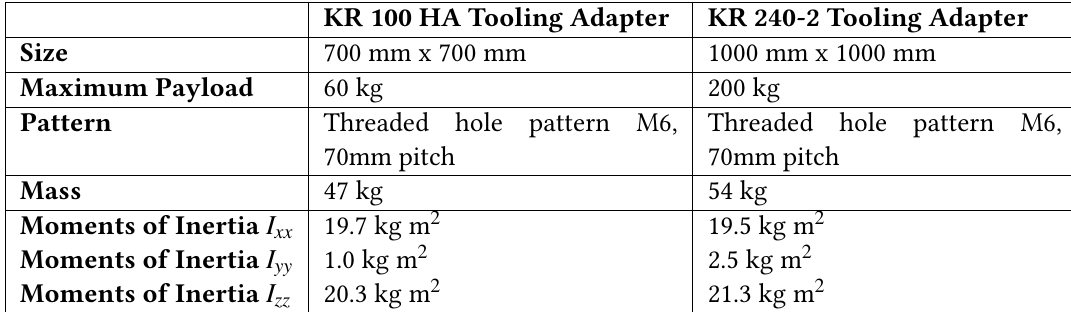
Table 5: The KUKA KR100 HA and KR240-2 Tooling Adapter